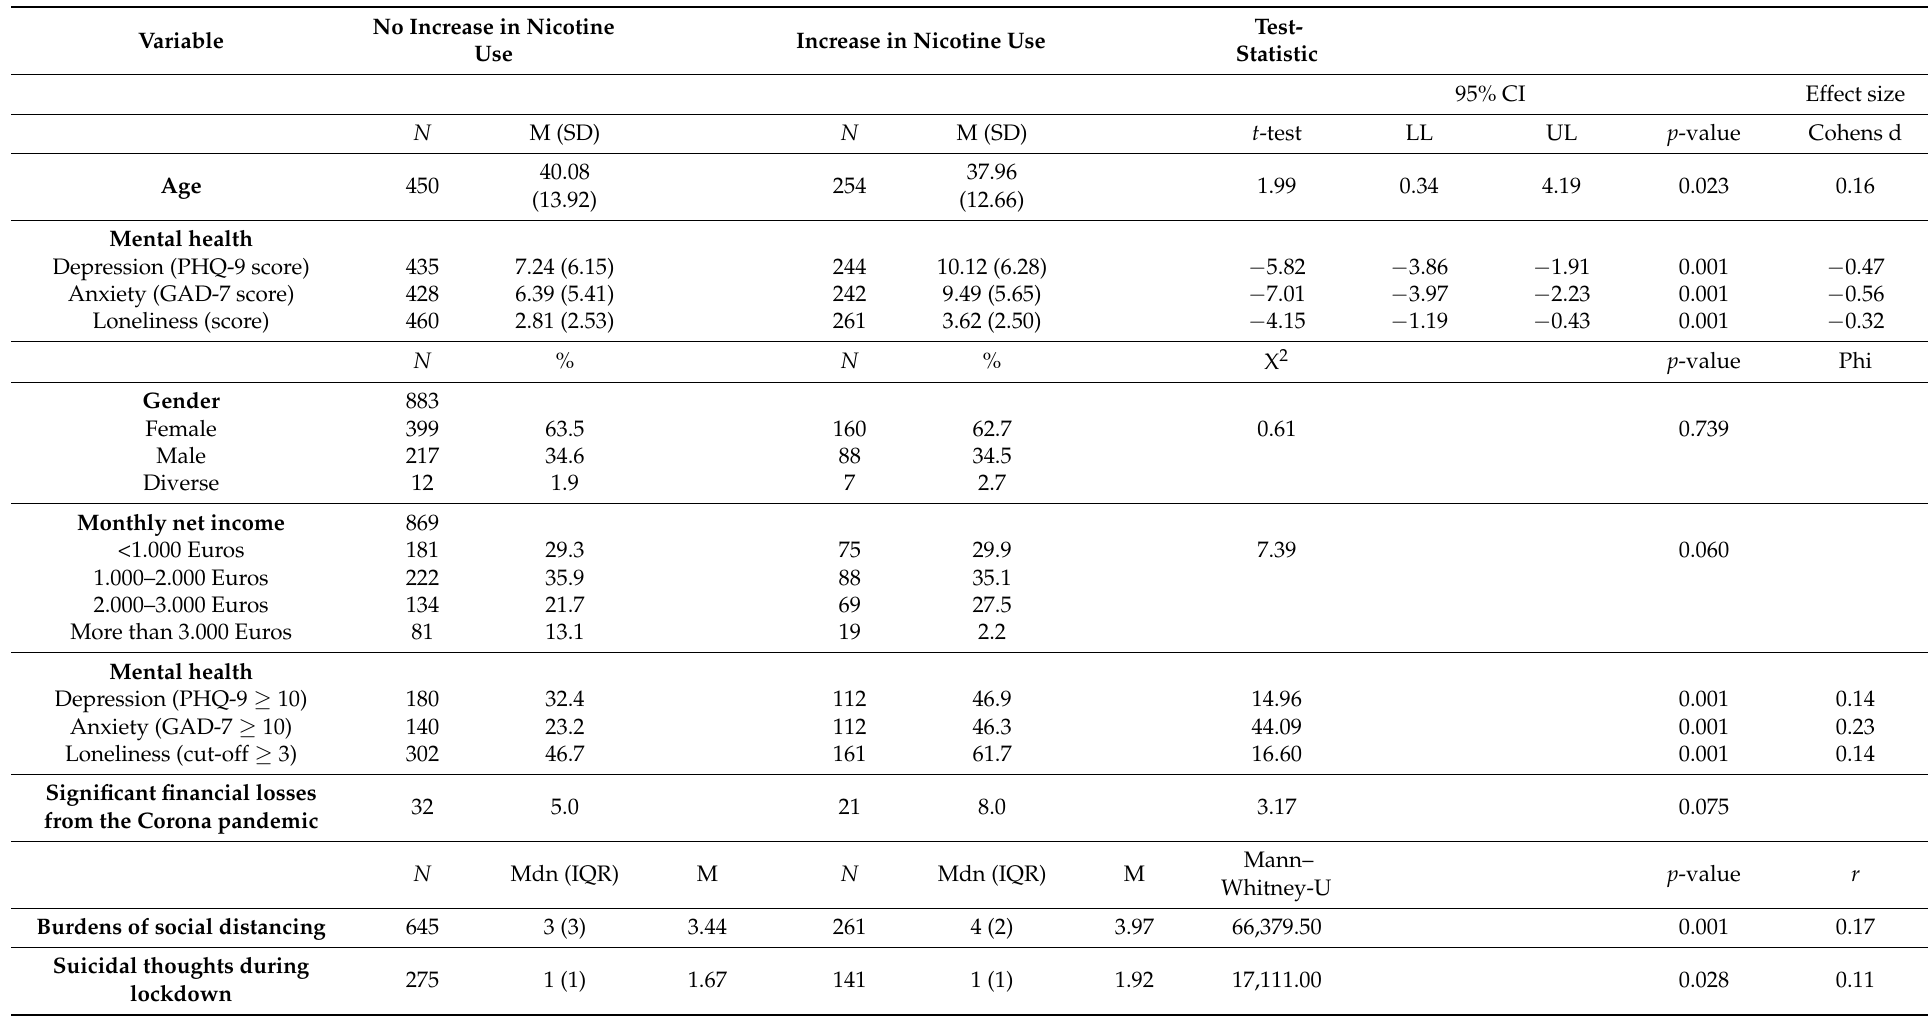
Table 7. Nicotine consumption and mental